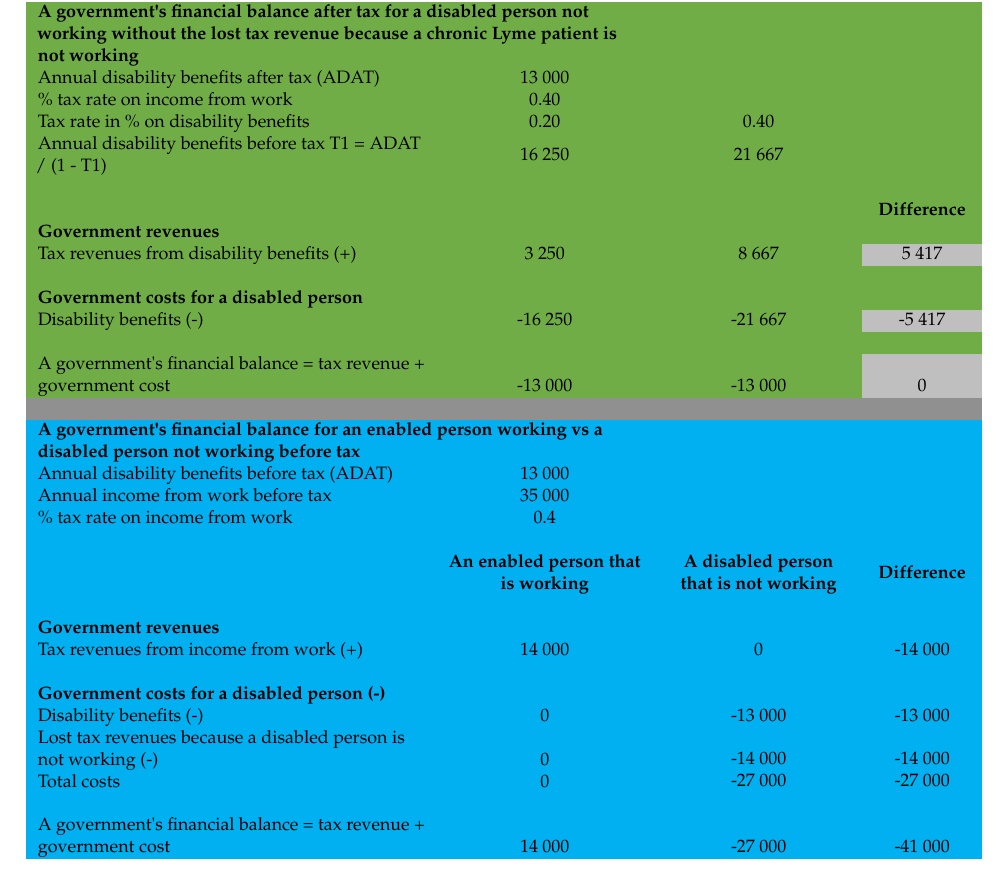
Table 10. A government’s financial balance (government revenues + government costs) with a disability benefit tax